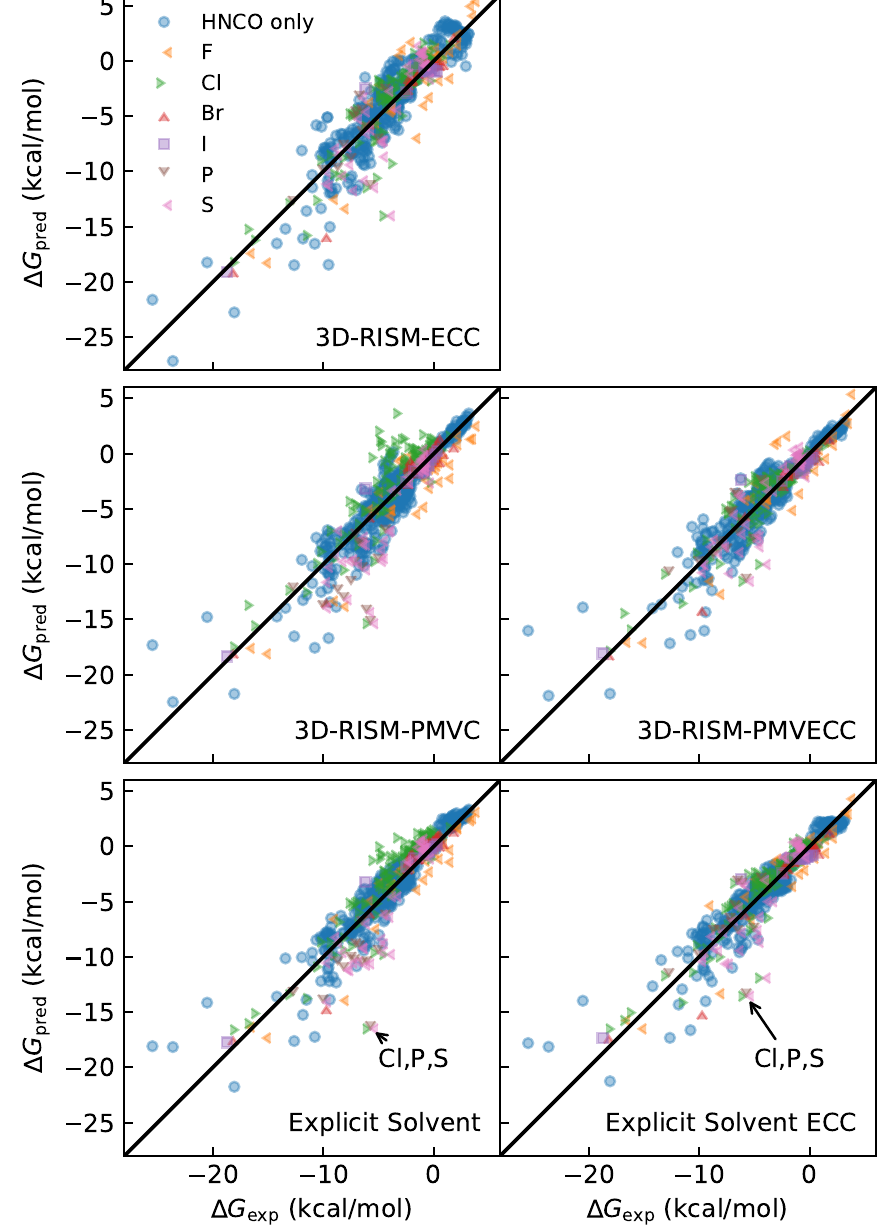
Figure 2. HFEs for 3D-RISM/PMVC, 3D-RISM/ECC, 3D-RISM/PMVECC, and explicit solvent using parameters from Table 1. Leave-out data were used for all plots, except for uncorrected explicit solvent calculations, which are from Refs. [22,35]. Molecules containing combinations of F, Cl, Br, P, and S atoms are plotted with multiple symbols (e.g., see labeled molecule in the bottom row). See Section 5.5 for details of the fitting